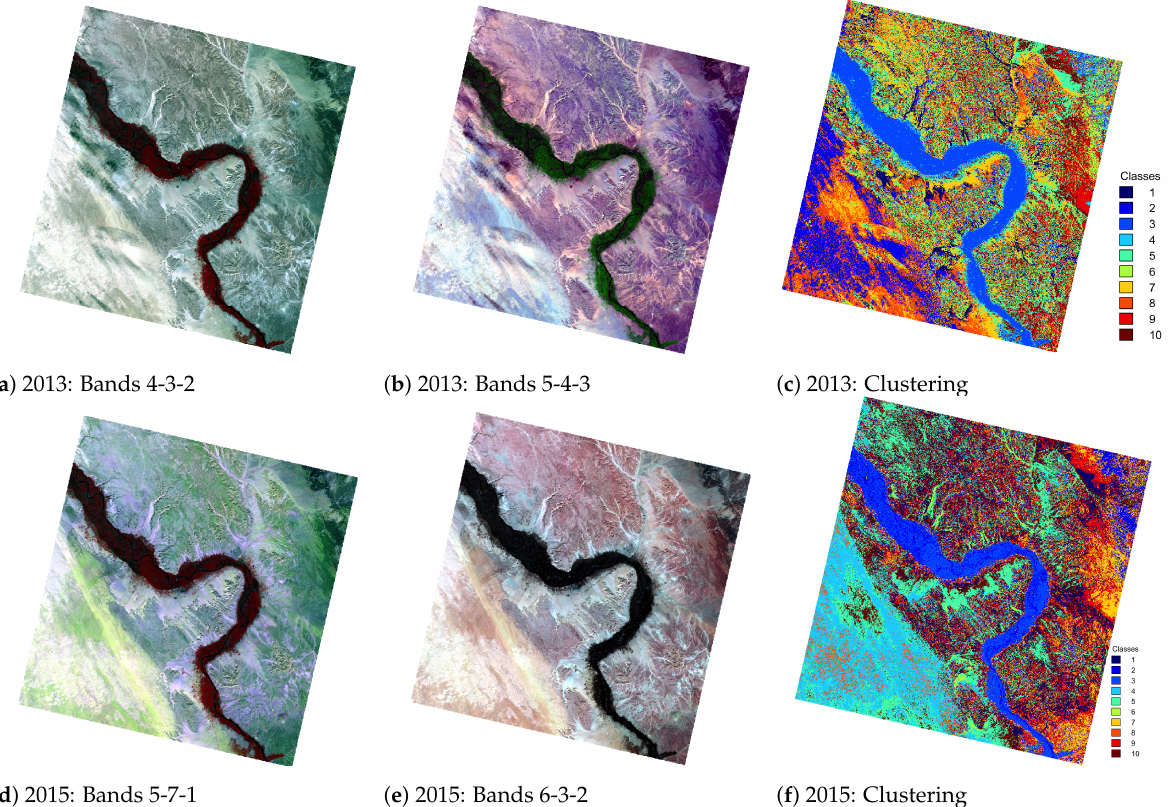
Figure 7. Qena Bend of the Nile River: false color composites and clustering of the Landsat 8-9 OLI/TIRS images: ( a ) 2013 RGB in 4-3-2 Bands, ( b ) 2013 RGB in 5-4-3 Bands, ( c ) 2013 unsupervised classification, ( d ) 2015 RGB in 5-7-1 Bands, ( e ) 2015 RGB in 6-3-2 Bands, ( f ) 2015 RGB: